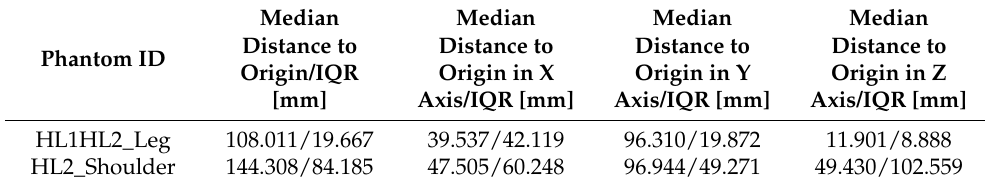
Table 3. Median distance of the AR control points to the origin of coordinates for each axis.